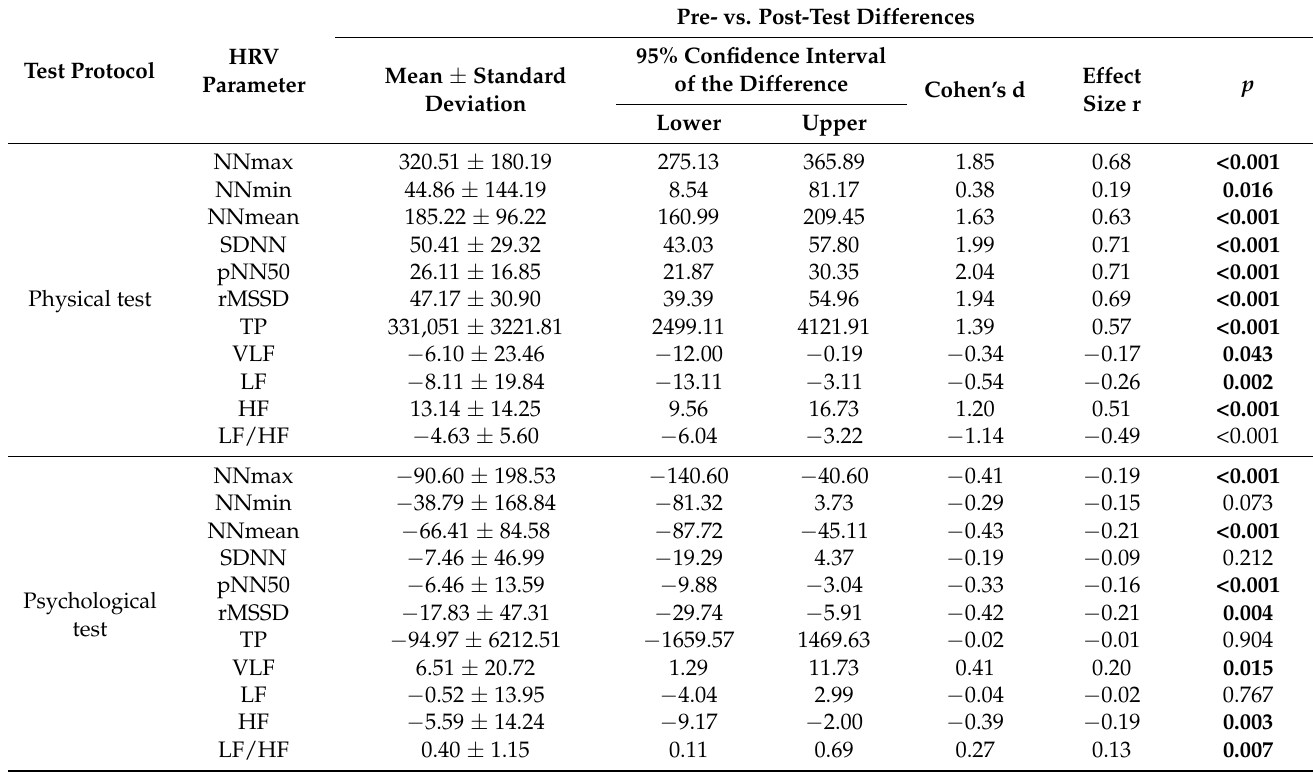
Table 1. Dependent t -test results of comparison of pre- and post-test HRV parameters (Bold p -values indicate significant differences).